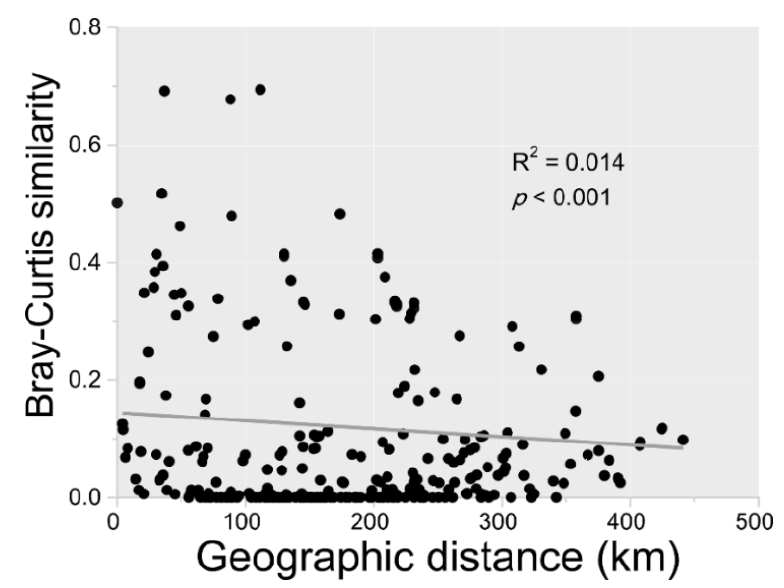
Figure 3. Relationship between the Bray-Curtis similarity of the microbial community and geographic distance between sampling stations. The solid line indicates the fit between geographic distance and Bray-Curtis